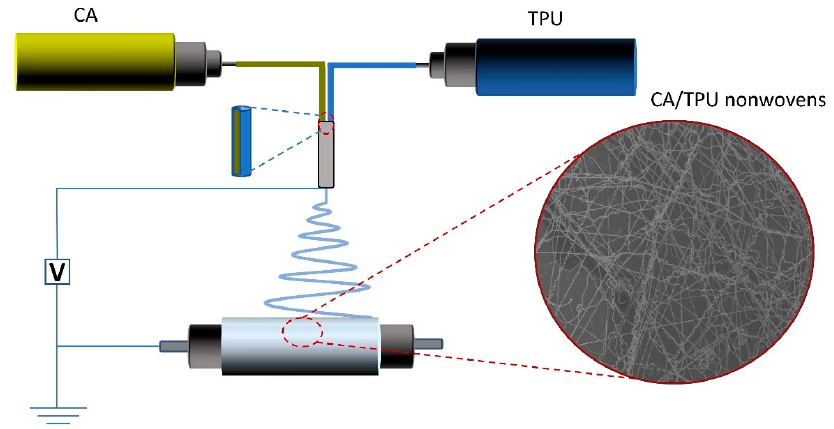
Figure 1. The schematic of co-electrospinning system and the SEM image of CA/TPU nonwovens.